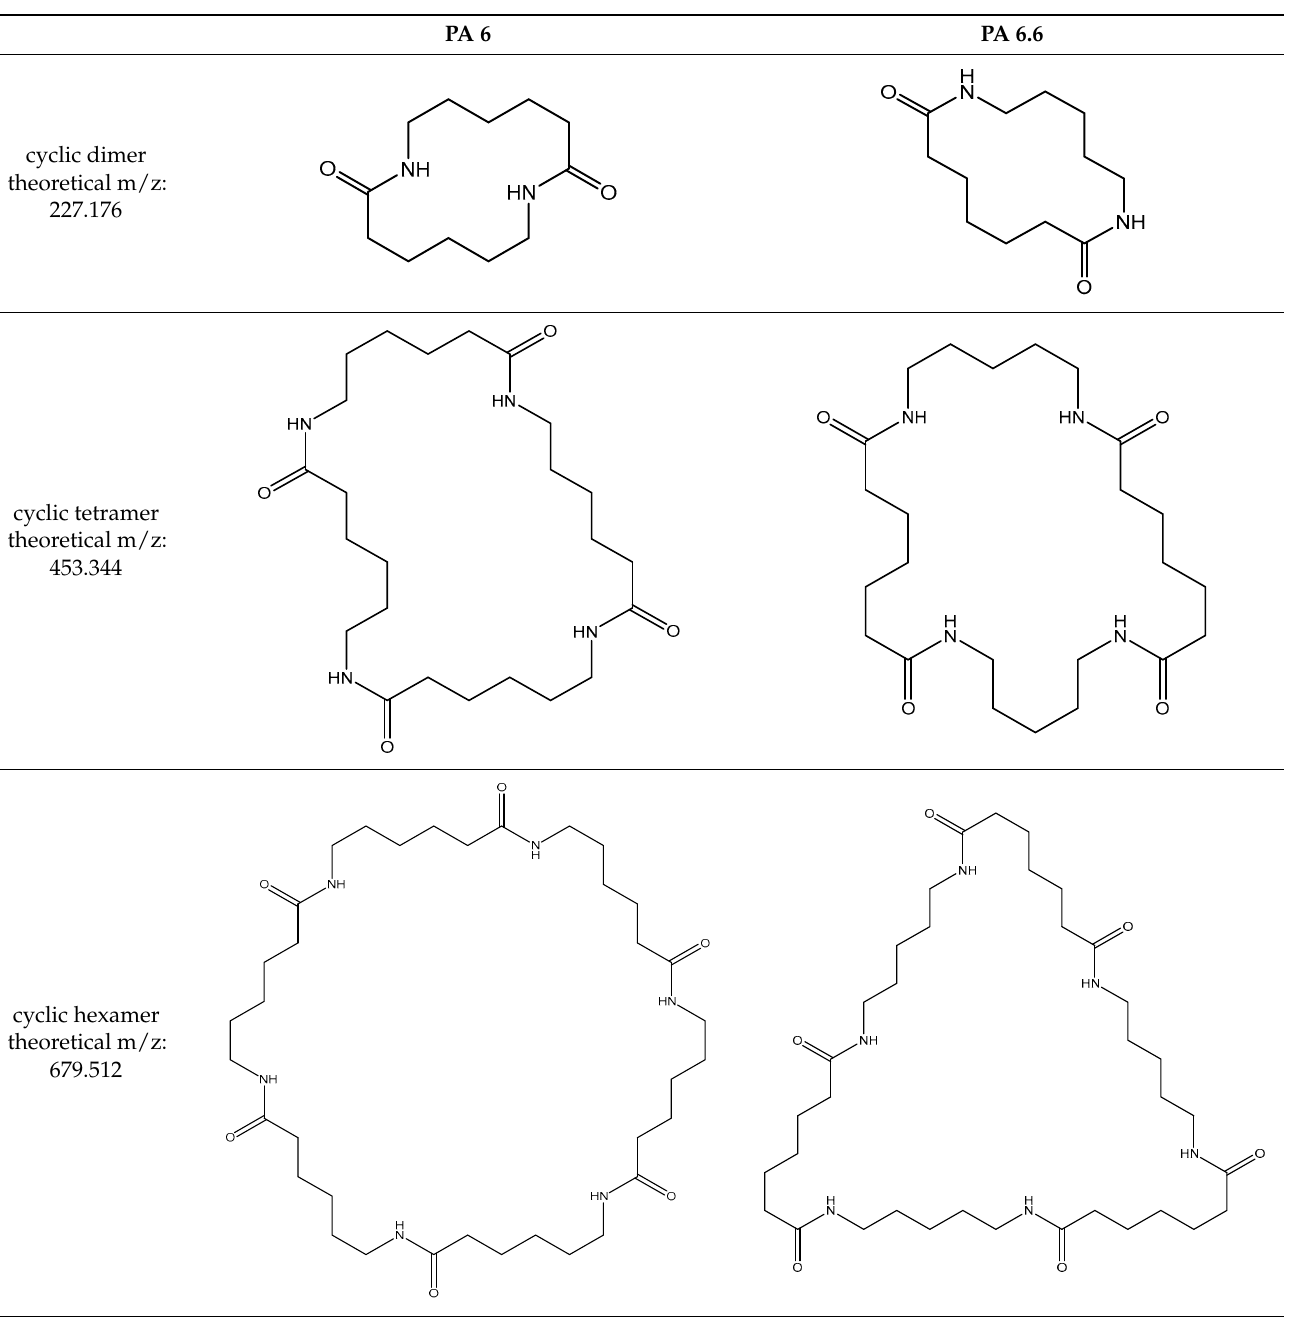
Table 2. Structures of the identified cyclic marker compounds for PA 6 and PA 6.6 having the identical exact mass.